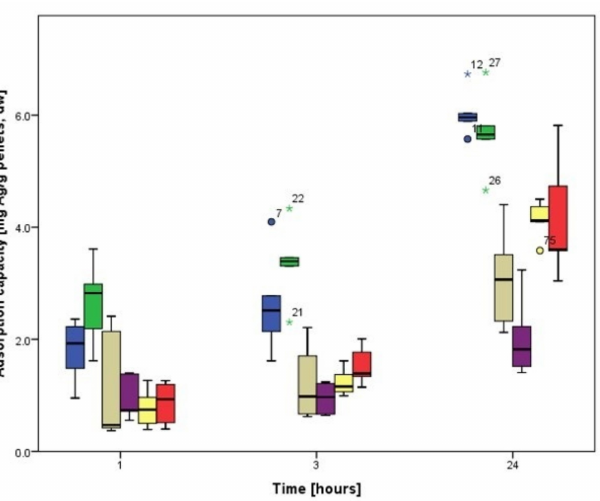
Figure 7. Ag adsorbed on Cladosporium cladosporioides pellets at different pH values and contact times. pH: (cid:4) : 2; (cid:4) : 3; (cid:4) : 4; (cid:4) : 5; (cid:4) : 6; (cid:4) :